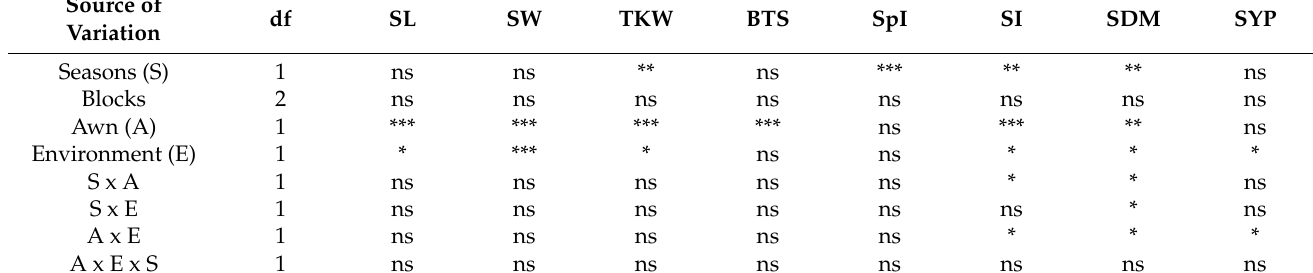
(Figure 3). The average SW was also decreased by awn excision under irrigated (awned, 2.06 mm; de-awned, 1.89 mm; p < 0.001) and rainfed (awned, 1.90 mm; de-awned, 1.75 mm; p < 0.001) conditions. Across both environments, the SpI was not significantly affected by awn excision ( p > 0.05). However, awn excision strongly increased the average SI under both irrigated (awned, 76.70; de-awned, 85.17; p < 0.01) and rainfed (awned, 72.73; de-awned, 82.81; p < 0.001) regimes. Table 2. Analysis of variance for awns (A), environments (E), seasons (S), and interaction effects on seed yield and yield components. SL, seed length; SW, seed width; TSW, thousand-seed weight; BTS, breaking tensile strength; SpI, spikelets per inflorescence; SI, seeds per inflorescence; SDM, spike dry matter; SYP, seed yield per plant. ns: not significant. *, **, and ***: significant at 0.05, 0.01, and 0.001 probability level. Source of